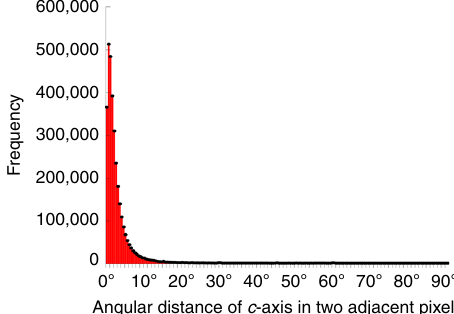
Fig. 6 Histograms of angular distances of crystalline c -axes. The angular distances, in three-dimensional space, between the c -axes in each two adjacent 60-nm pixels, measured across all the pixels in Fig. 2. Almost all angular distances are below 30° and the peak is at 1°. Supplementary Fig. 11 shows additional histograms acquired every 2, 4, 8, 16, 32, 64, 128, or 256 pixels, demonstrating that orientations change gradually from pixel to pixel, thus from crystal to crystal within all enamel components. Small spikes around 30°, 40°, 45°, 50°, and 60° corresponds to rod – interrod interfaces without organic